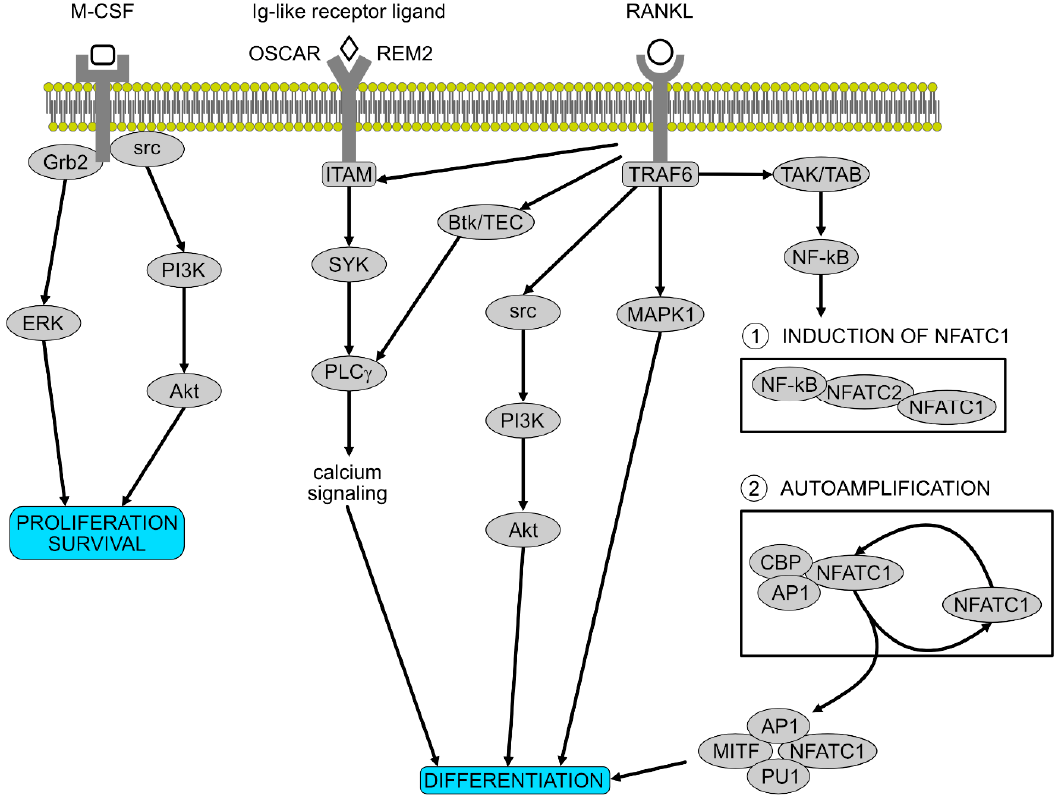
Figure 2. Molecular pathways involved in osteoclast proliferation and differentiation. M-CSF is essential for the proliferation and the survival of the osteoclast precursors. After activation, it recruits Grb2 and src which induce ERK and PI3K pathways. RANKL is the most important differentiation factor, activating numerous pathways involved in osteoclasts differentiation, including the two stages governed by NFATC1. Ig-like receptor ligands on osteoclast precursors synergize with the RANK signalling.